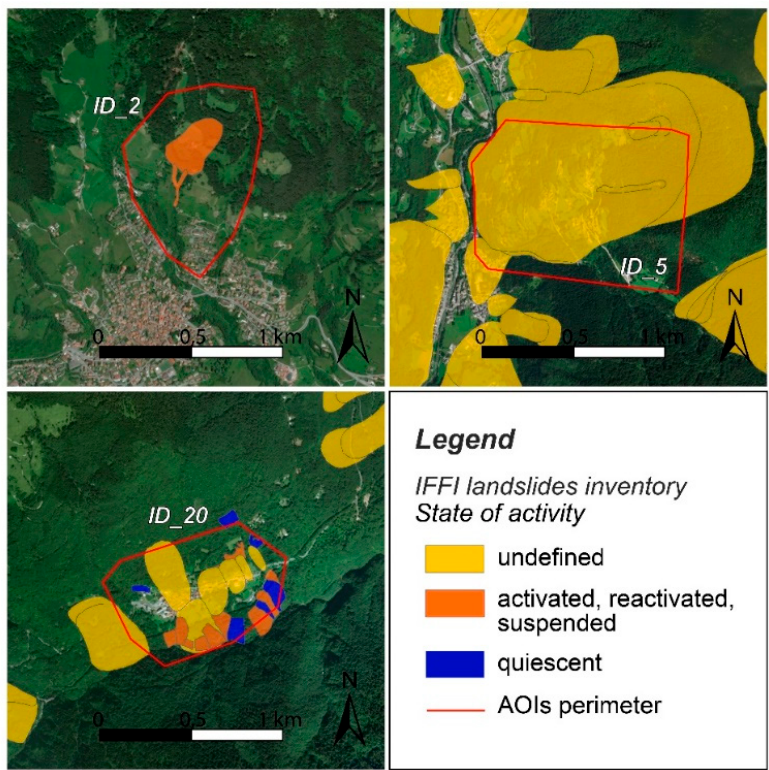
Figure 4. Areas of interest (AOIs): Three examples that show different situations as regards the presence of mapped landslides and their state of activity, reported by IFFI catalog [38].